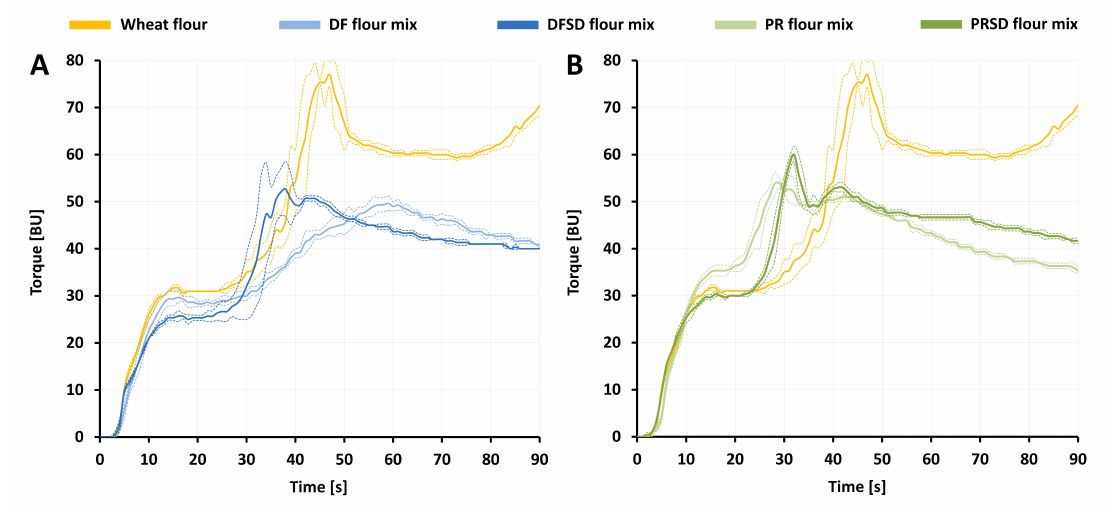
Figure 2. Flour properties of wheat flour and HP flour mix: (Gluten-aggregation profiles obtained by GlutoPeak test: ( A ) DF flour mix, DFSD flour mix compared to wheat flour; ( B ) PR flour mix and PRSD flour mix compared to wheat flour. Dashed curves represent standard